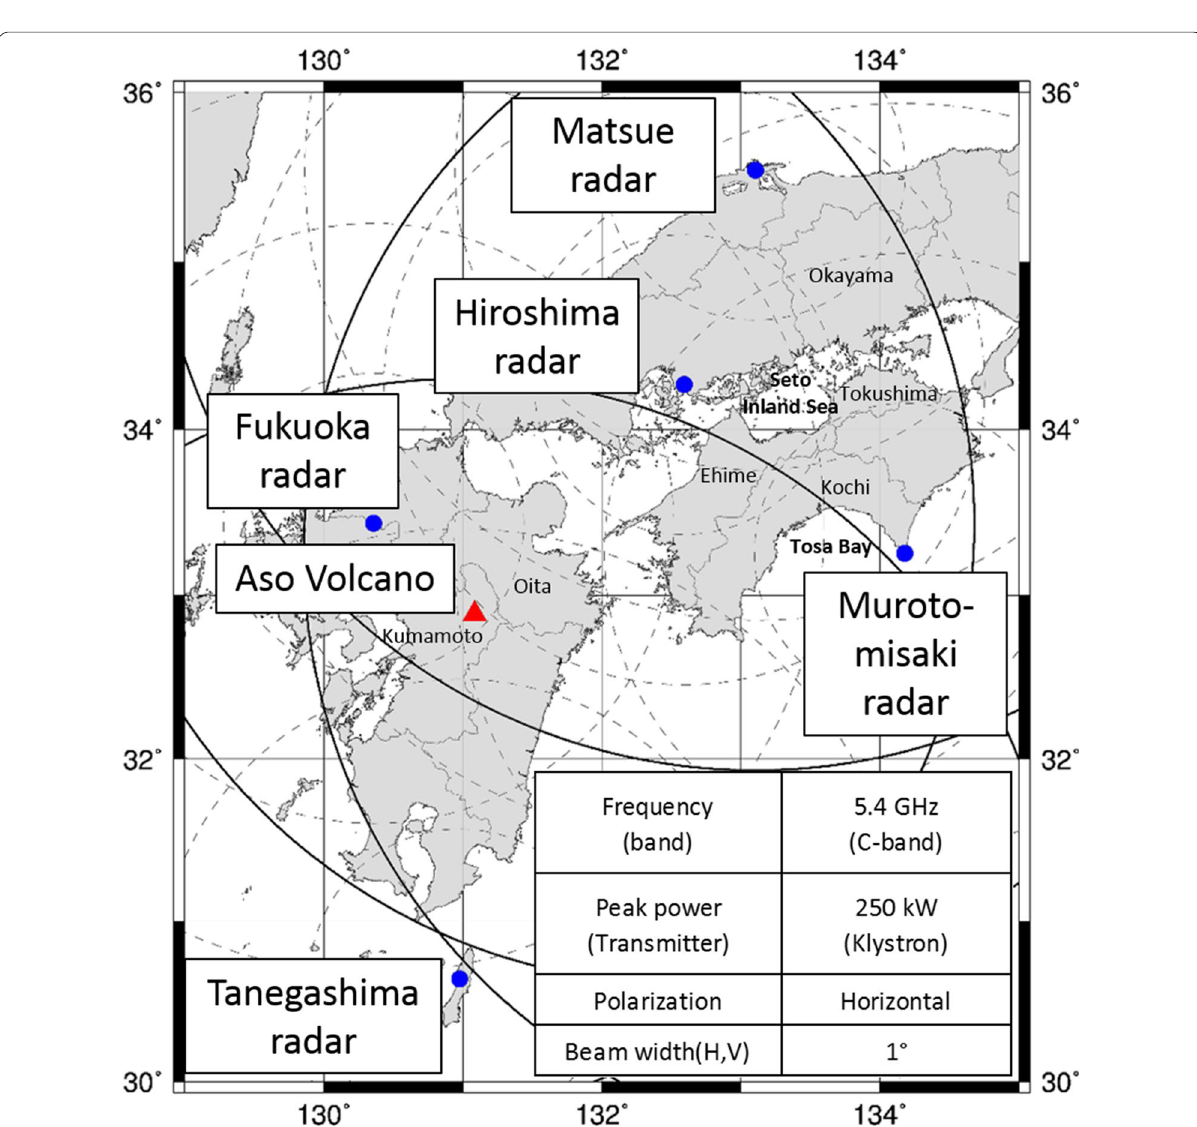
Fig. 1 Map of radars ( ) around Aso volcano ( ) and main specifications of JMA-RDN. Dashed concentric circles show 100, 200 and 300 km from each radar. Solid concentric circles show 400 km, which correspond to the maximum